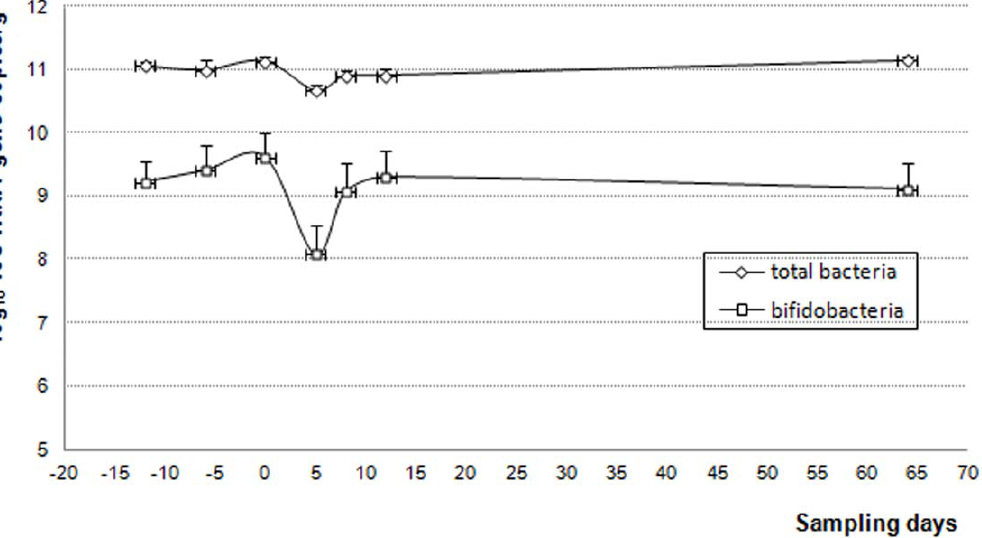
Figure 1. Monitoring of total bacteria and bifidobacterial counts using qPCR before and after AMC exposure (day0–day5).